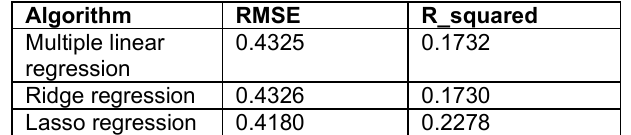
Table 3. Comparing results of algorithms